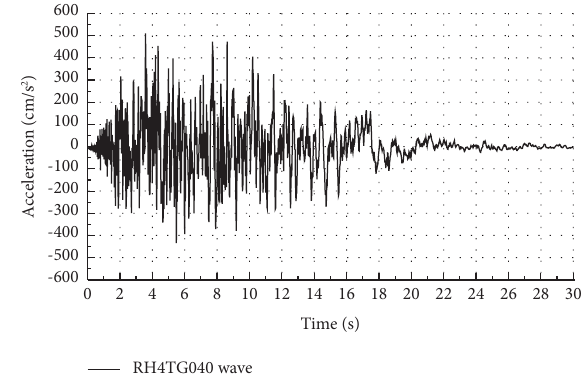
Figure 8: Time-history curve of RH4TG040.